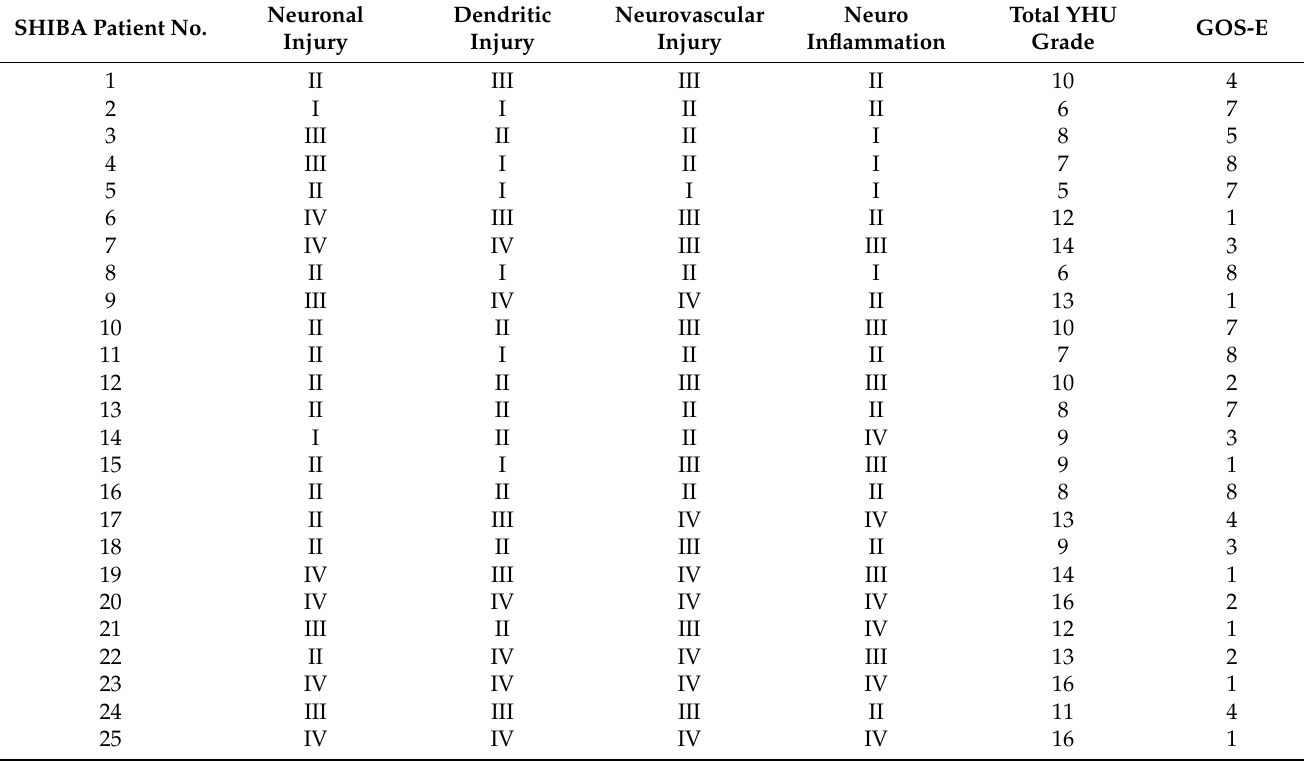
Table 3. Neuropathological examination of fresh brain biopsy samples from the SHIBA patient cohort. The Roman numerals in columns 2–5 represent the YHU grading scales presented in Figures 2–5. Total YHU grade is the sum of the grade scores of the 4 injury categories. Patient death or level of disability at 6 months post injury is defined by the GOS-E